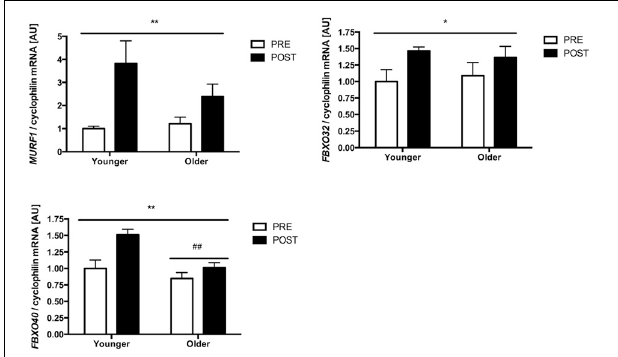
FIGURE 1 | MURF1 , atrogin-1 ( FBXO32 ) and FBXO40 mRNA expression following a single-bout of resistance exercise in younger and older people. Note that no changes were observed for the other genes measured. ∗ significant exercise effect, p < 0 . 05, ∗∗ significant exercise effect, p < 0 . 01, ##significantly different from Young, p < 0 . 01. The reported statistical significance is based on analysis of the transformed data but the reported means ± s.e.m. are on the original (untransformed) scale.